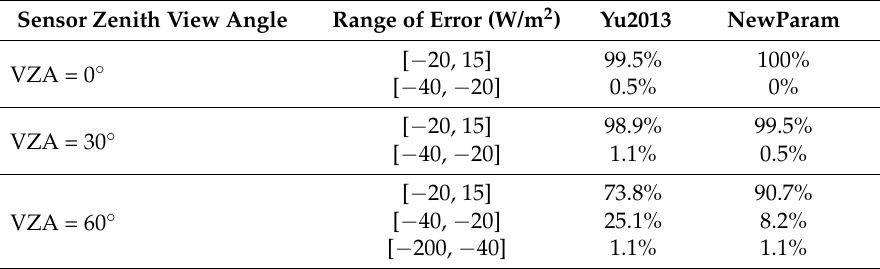
Figure 5. DLRs calculated from testing dataset using the Yu2013 ( a , c ) and new parameterizations ( b , d ), respectively. The algorithms coefficients were deriving from TIGR2002 profiles. Figures ( a , b ) show the comparison between the estimated and the MODTRAN-simulated DLRs. Figures ( c , d ) show the residuals of the predicted DLR, which vary with water vapor content for different VZAs, assuming δ T s,a = 0 K. Table 2. Error distribution statistics for IWV greater than 3.0 cm and δ T s,a = 0 K.